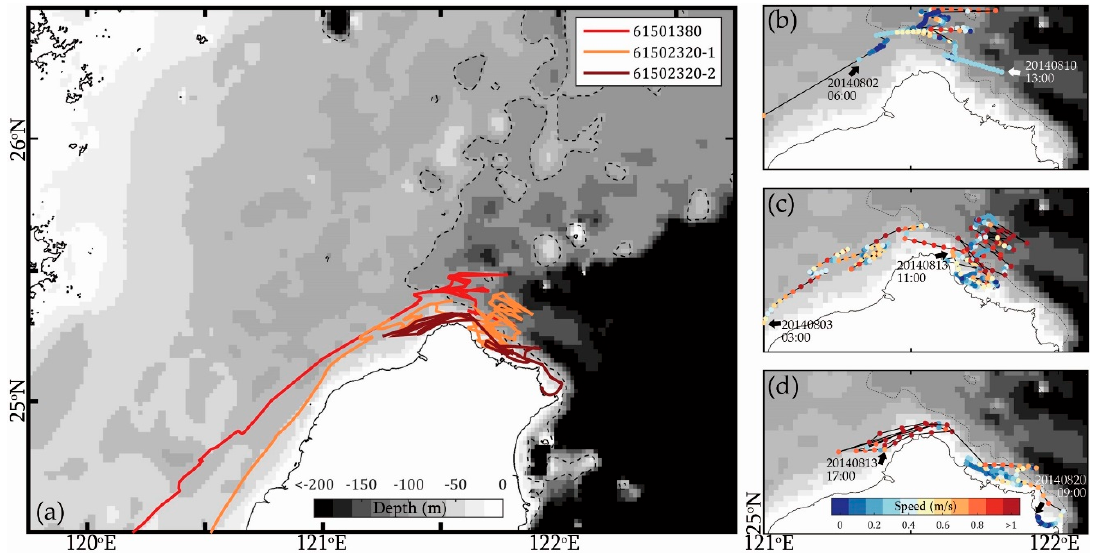
Figure 4. ( a ) Three trajectories of drifters in the Taiwan Strait in summer. ( b ) ID : 61501380, ( c ) ID : 61502320-1, and ( d ) ID : 61502320-2.